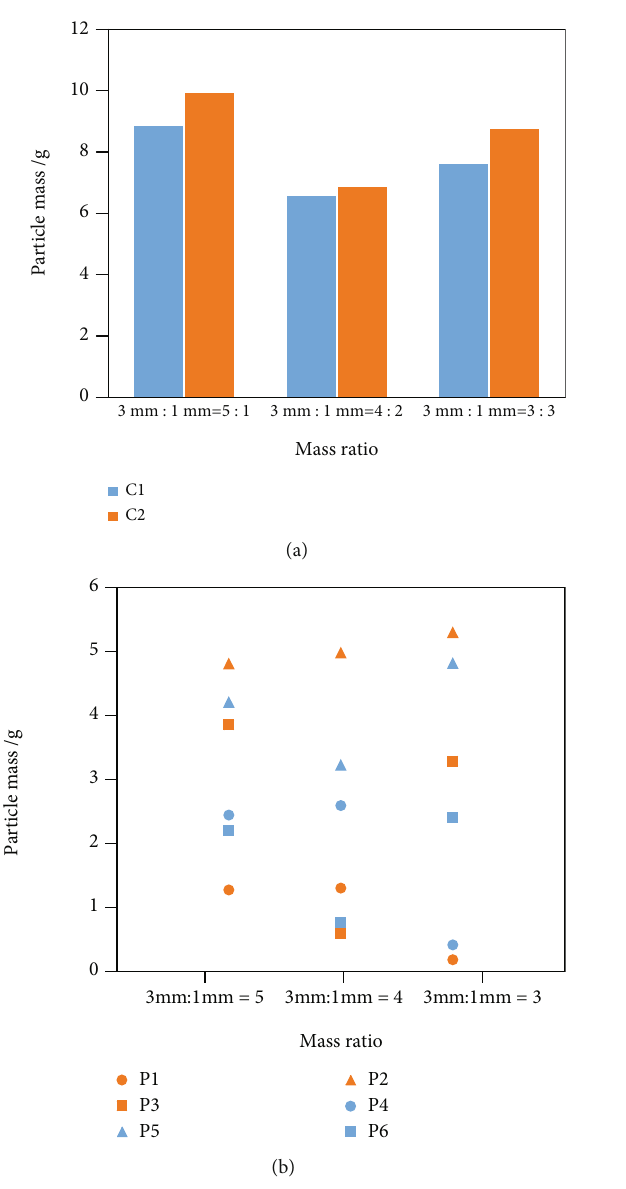
Figure 6: Settling mass of particles with di ff erent mass ratios in each cluster (a) and perforation (b) (orange red is the perforation at the outlet end, blue is the perforation at the inlet end, and P represents the perforation). Table 3: Variable displacements experiment scheme table.